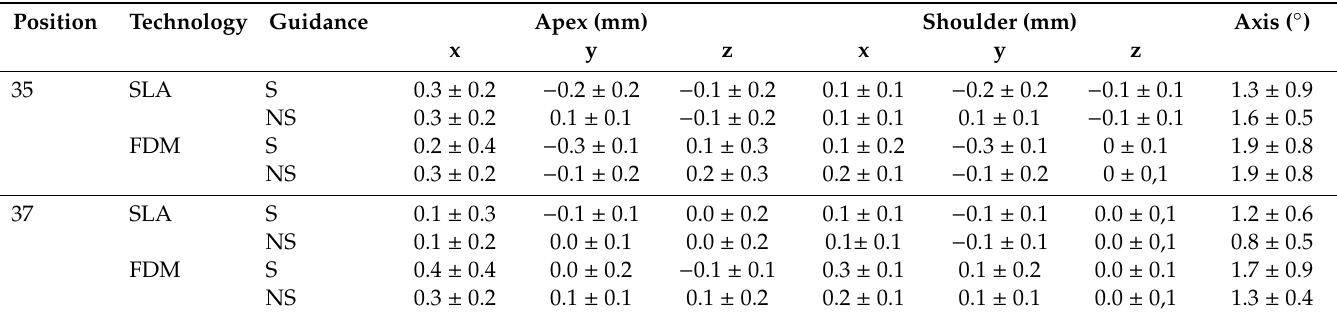
Table 1. Mean ± standard deviation of the discrepancies at the implant apex and shoulder level and the main axis.